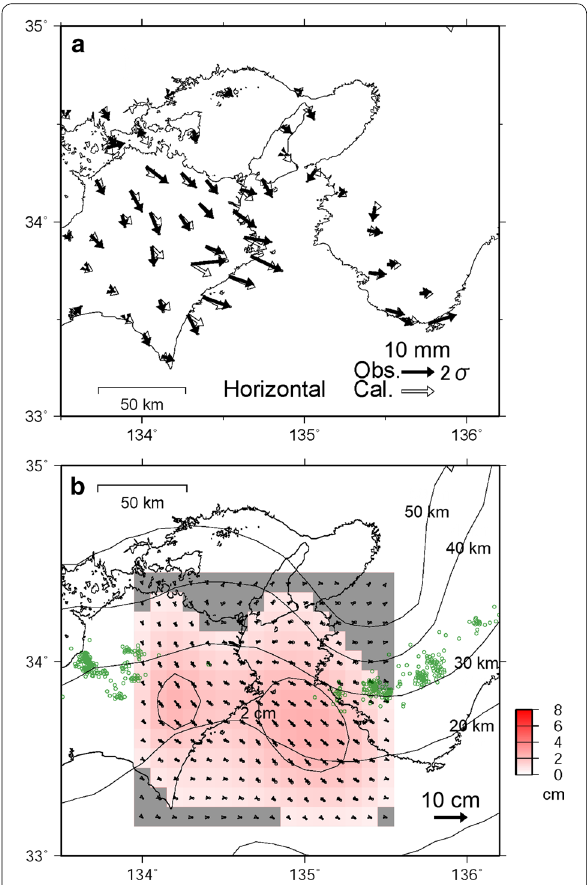
Fig. 7 Horizontal unsteady displacements and estimated slip distribution in eastern Shikoku and Kii Channel for the period January 2000 to January 2003. a Horizontal displacements used for estimating slip. Black arrows indicate observations, and white arrows indicate cal- culated values. Ellipses at the top of arrows indicate 2 σ errors inferred from standard deviations of coordinates over a 1-month period. b Estimated slip distribution. Slip arrows indicate the motion of the overriding plate with respect to the subducting Philippine Sea plate. Small circles at the tips of arrows indicate the estimation errors. Gray shading indicates the area where the slip amount is smaller than the error. Green circles indicate epicenters of deep low-frequency earth- quakes from January 2000 to January 2003 of the Japan Meteorologi- cal Agency earthquake catalog. Contours show the depth of the top of the subducting Philippine Sea plate (Hirose et al. 2008)